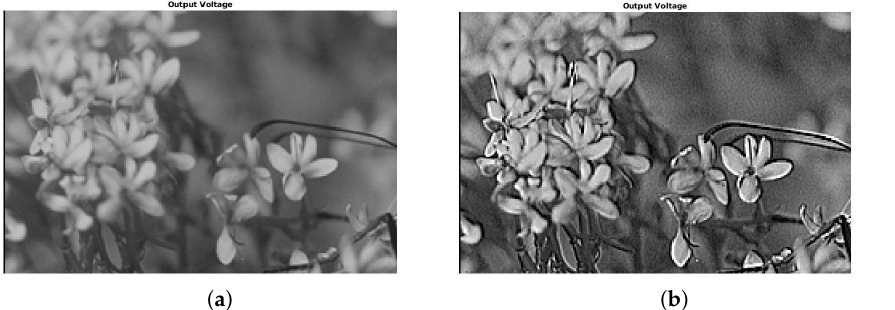
Figure 10. Example 2: Zoom-in of Figure 9a,d, showing a detail of the sharpening results obtained using the proposed stochastic computing CNN. ( a ) Zoom-in of the original image. ( b ) Zoom-in of the sharpened image.